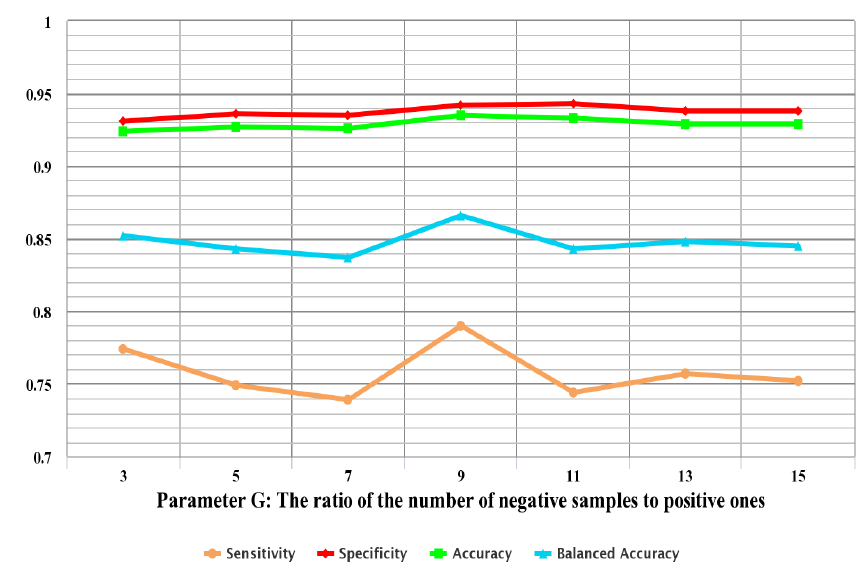
Figure 2. The 10-fold cross-validation performance trained with different values of G . Parameter G is defined as the ratio of the number of negative samples to positive ones after random